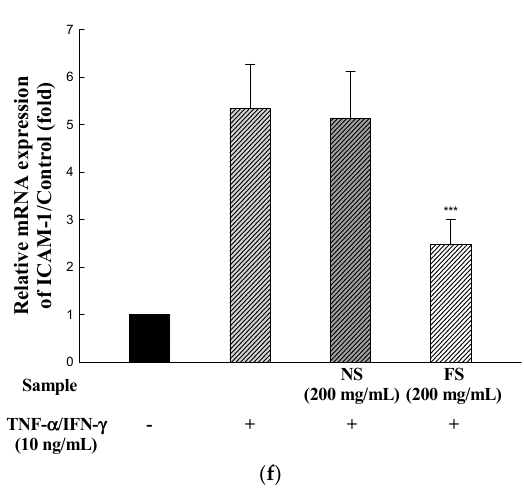
Figure 3. Effects of NS and FS extracts on TNF- α /IFN- γ -induced mRNA expression in HaCaT cells. RT-PCR was performed to determine the mRNA expression levels of IL-1 β , IL-6, ICAM-1, TARC, and MDC ( a ); The intensities of the PCR bands for IL-1 β ( b ); IL-6 ( c ); ICAM-1 ( d ); TARC ( e ); MDC ( f ). Each bar represents the mean ± SD of triplicate determinations, n = 3; * p < 0.05, ** p < 0.01, *** p < 0.001 vs. TNF- α /IFN- γ treatment alone. +, TNF- α /IFN- γ treatment; − , TNF- α /IFN- γ untreated.